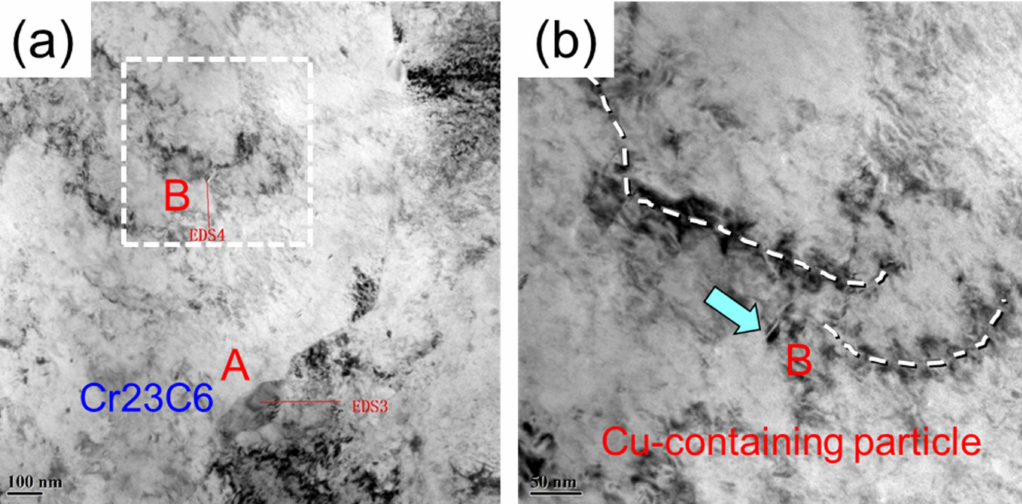
Figure 8. The dislocation pile-up and multiplication around the precipitates during the tensile test of Cu-bearing age- hardening steel. ( a ) interaction between precipitates and dislocations; ( b ) a zoomed-in image of the white dashed area in ( a ), showing the dislocation pile-up and multiplication resulted from Cu-rich